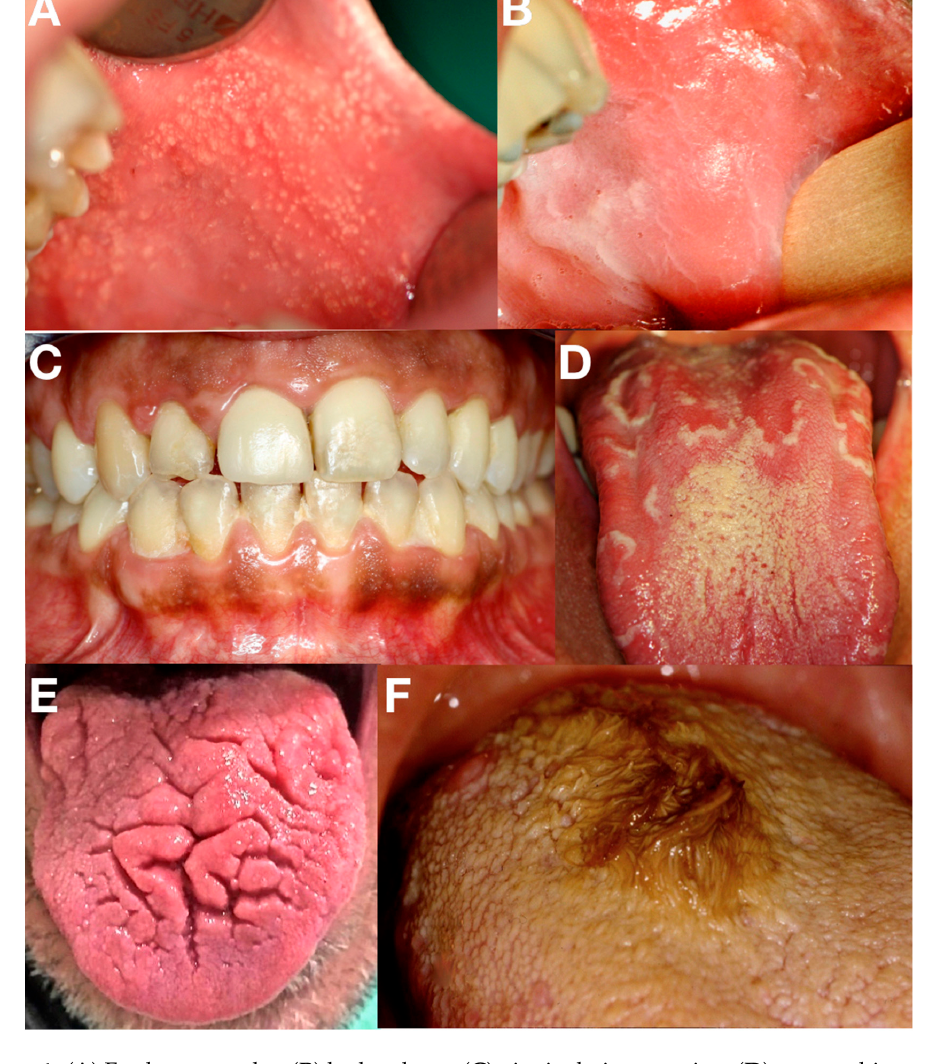
Figure 1. ( A ) Fordyce granules; ( B ) leukoedema; ( C ) gingival pigmentation; ( D ) geographic tongue; ( E ) fissured tongue; ( F ) black hairy tongue.